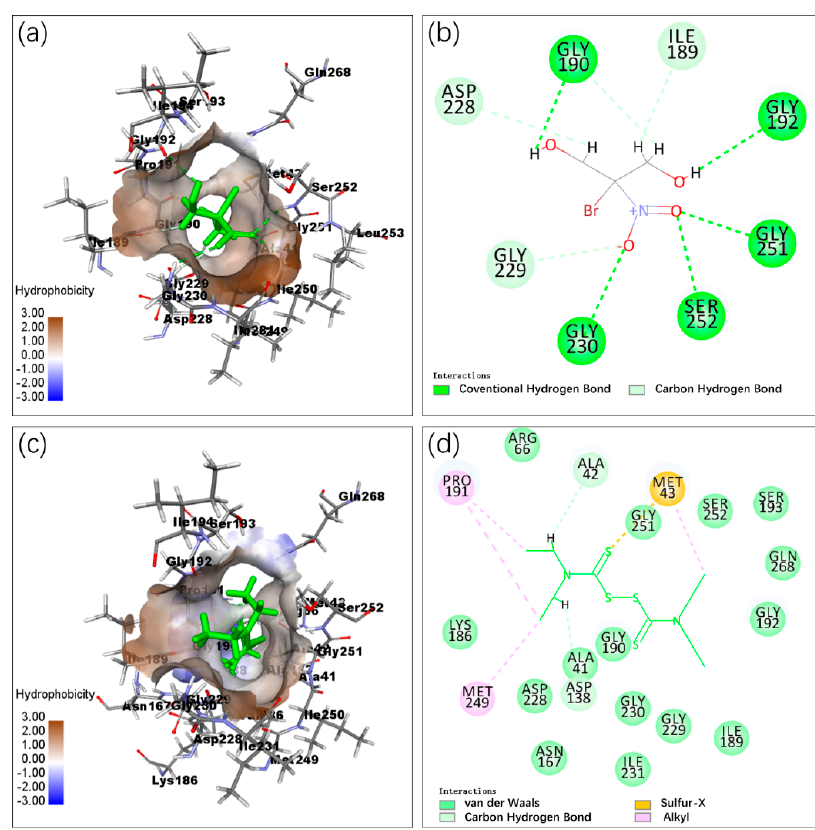
Figure 3. Molecular docking of C Las IMPDH Δ 98 ‐ 201 and the moleculars. ( a ): 3D details of C Las IMPDH Δ 98 ‐ 201 and bronopol (green) interaction; ( b ): 2D details of C Las IMPDH Δ 98 ‐ 201 and bronopol interaction; ( c ): 3D details of C Las IMPDH Δ 98 ‐ 201 and disulfiram (green) interaction; ( d ): 2D details of C Las IMPDH Δ 98 ‐ 201 and disulfiram interaction.